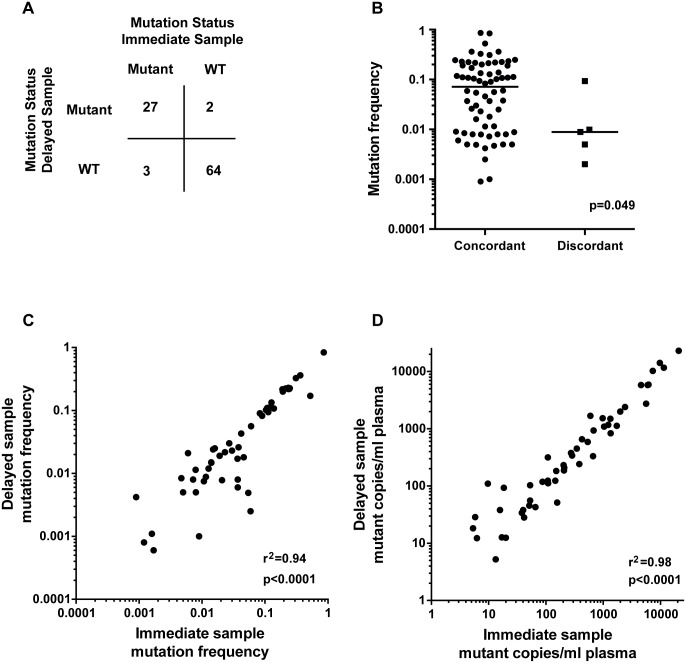
Agreement in mutation calling between immediate EDTA and delayed Streck tubes.A. Contingency table for mutation detection on immediately processed tubes versus delayed processing tubes,. B. Scatter plot of mutation allele frequency in concordant vs discordant samples. Mann Whitney U test. C. Correlation of mutational allele frequent frequency on immediate and delayed processing tubes. Pearson correlation coefficient. D. Correlation of mutant copies per ml of plasma in immediate and delayed processing tubes. Pearson correlation coefficient.